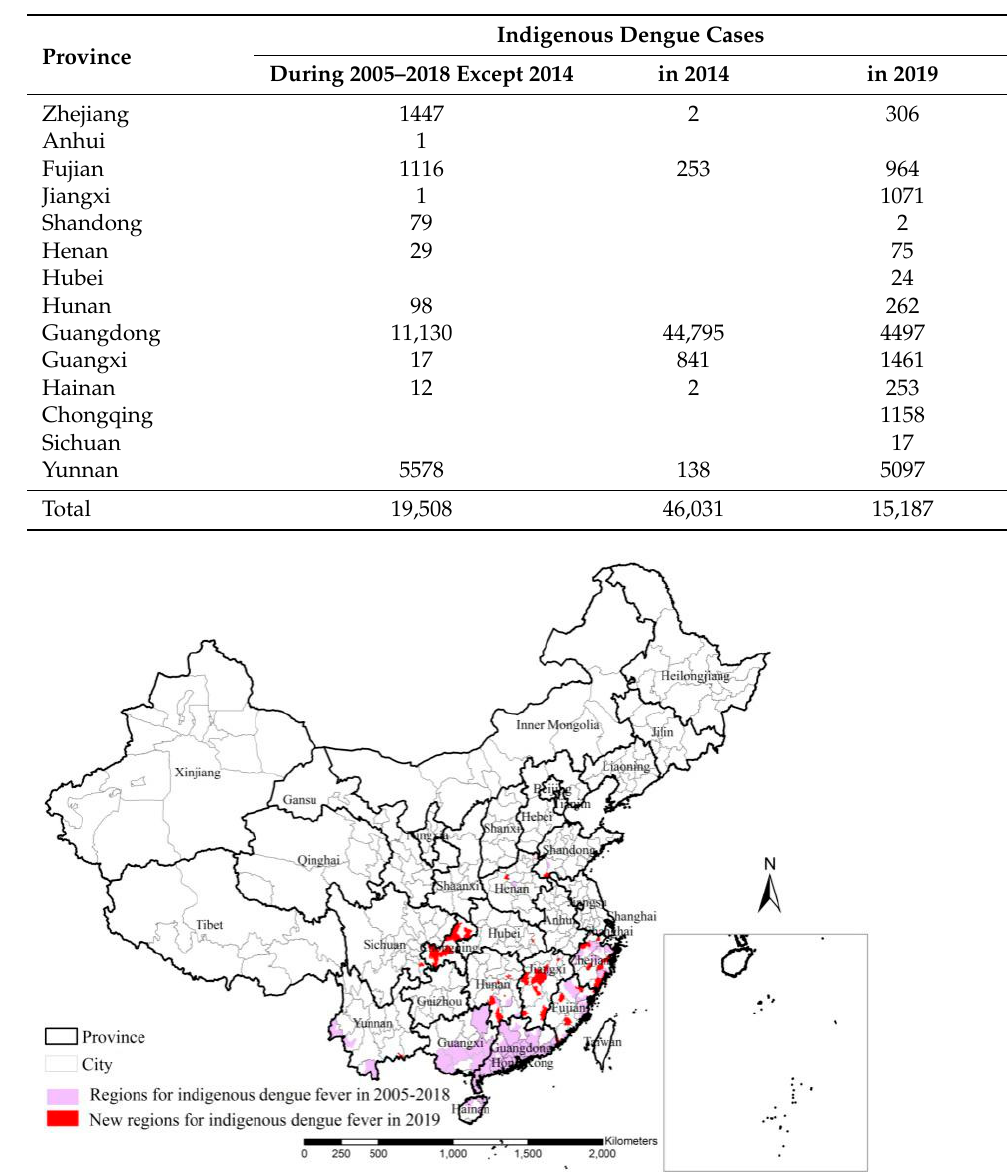
Table 1. Comparative analysis of indigenous dengue cases between 2019 and 2005–2018.